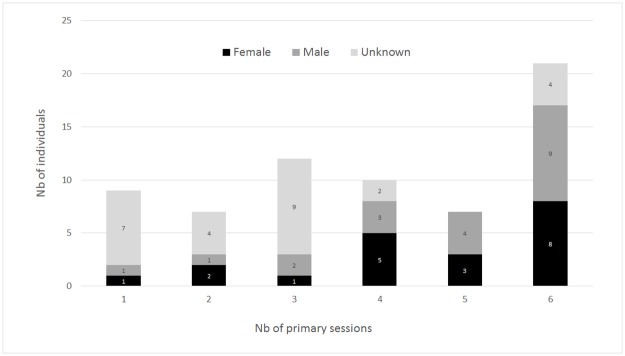
Distribution of the number of individual dolphins sighted in one to six primary sessions (2009–2014) off the west coast of Reunion, according to gender (female, male or unknown).